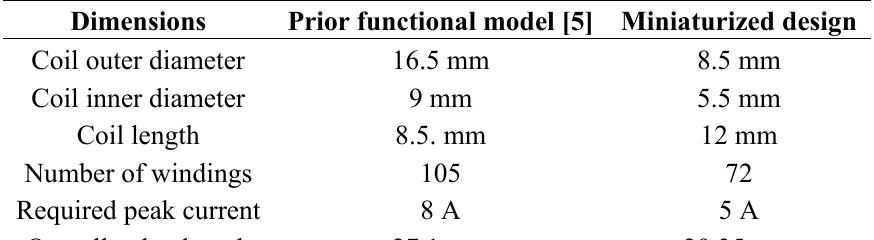
Table 1. Comparison of the dimensions of the prior functional model [5] and the miniaturized design of the disposable, electromagnetic dispensing valve.